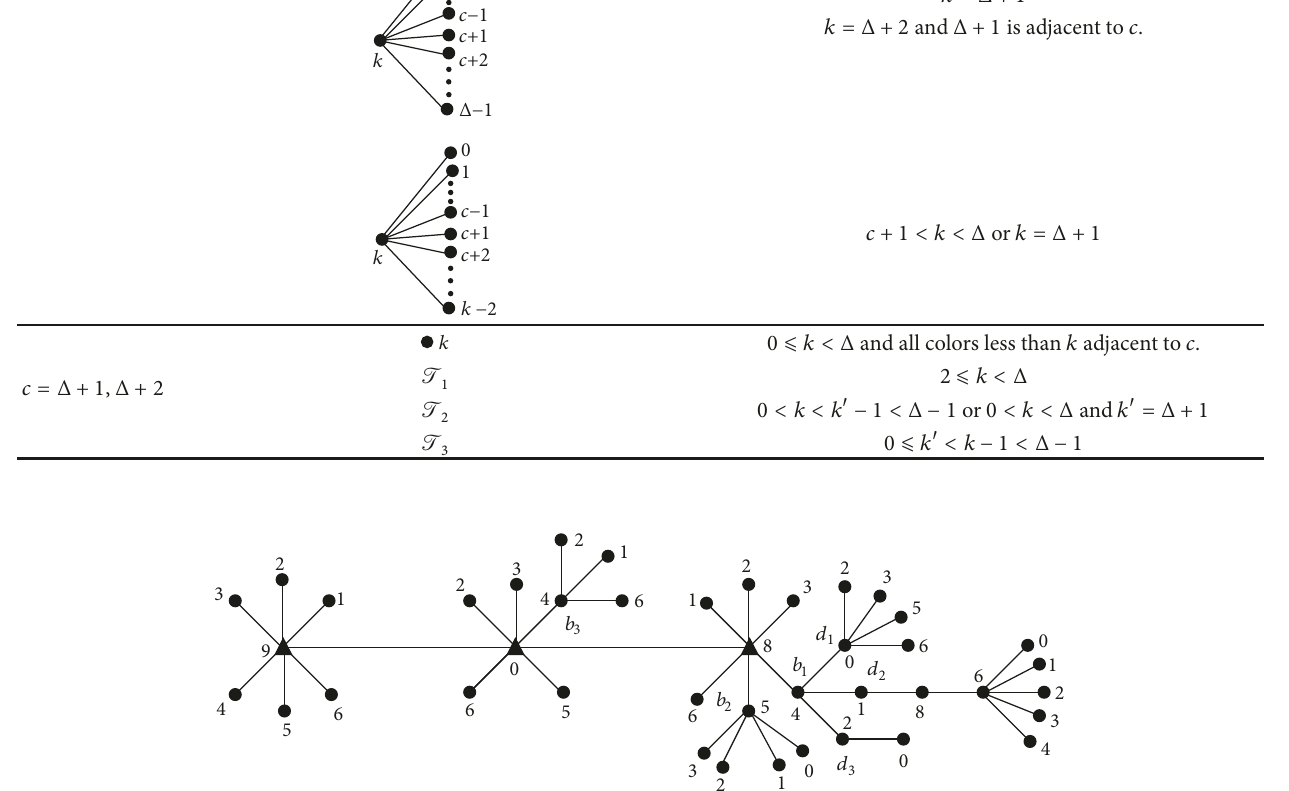
Figure 9: A tree with maximum number of holes one constructed from 𝑇 1